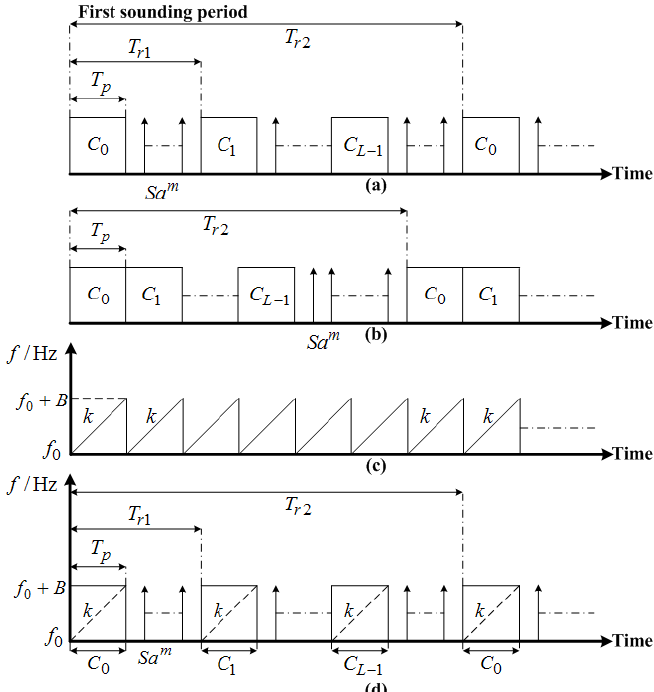
Figure 5. Sounding timing of the four types of waveforms employed in WIOBSS. ( a ) The inter-pulse binary phase-coded pulse trains. ( b ) The intra-pulse binary phase-coded waveform. ( c ) The linear frequency-modulated continuous waveform (LFMCW). ( d ) The inter-pulse pseudo-random binary phase-coding waveform where the sub-pulse uses the chirp modulation. T p represents the pulse width, L denotes the length of the coding sequence, T r 1 denotes the pulse repetition period, T r 2 denotes the sequence repetition period, C l is the element of {+1, − 1} in a pseudo-random coding sequence, l = 0, · · · , L − 1, Sa m represents the received echo at the m th range bin, k is the chirp rate, f 0 represents the initial center frequency of the chirp signal, and B is the sweep bandwidth of the chirp signal.